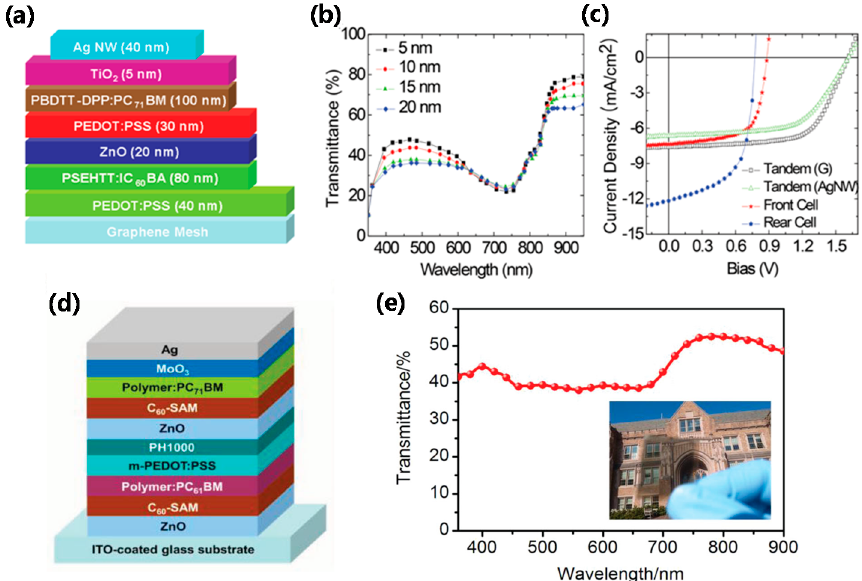
Figure 7. ( a ) Schematic diagram of a typica tandem STOSC; ( b ) Optical transmittance of the tandem cell with different TiO 2 thicknesses; ( c ) J - V curves of front, rear, and tandem cells (light projected from graphene mesh or Ag NWs) Reprinted with permission from [61]. Copyright 2014 Wiley. ( d ) Schematic representation of the tandem device architecture; ( e ) Optical transmittance of the tandem STOSC. The inset shows a photograph of the cell. Reprinted with permission from [62]. Copyright 2013 Wiley.